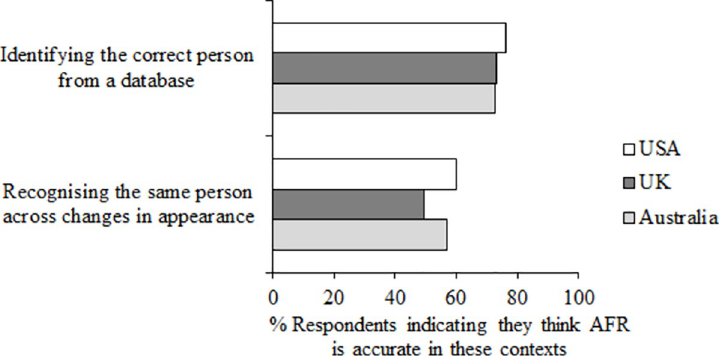
https://doi.org/10.1371/journal.pone.0258241.g010